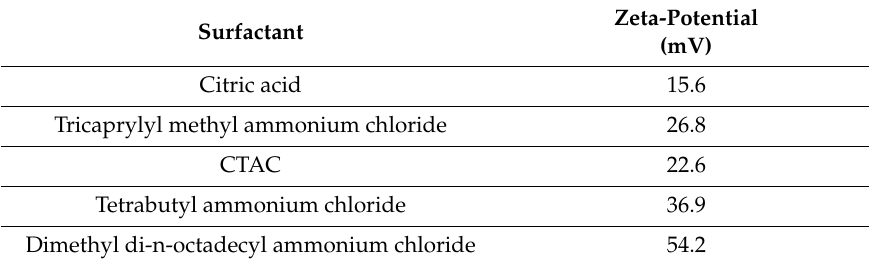
Table 1. Stability of Fe 3 O 4 @SiO 2 -NH 2 with di ff erent surfactants.